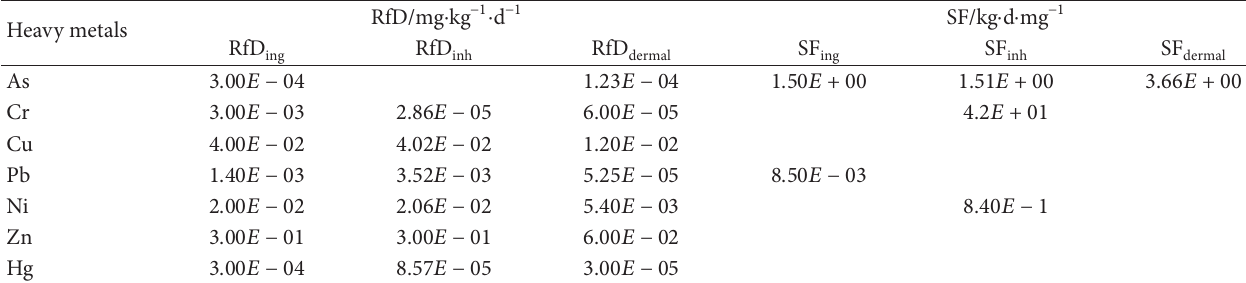
Table 3: Reference doses (RfD) for noncarcinogens and slope factors (SF) for carcinogens [20, 33,